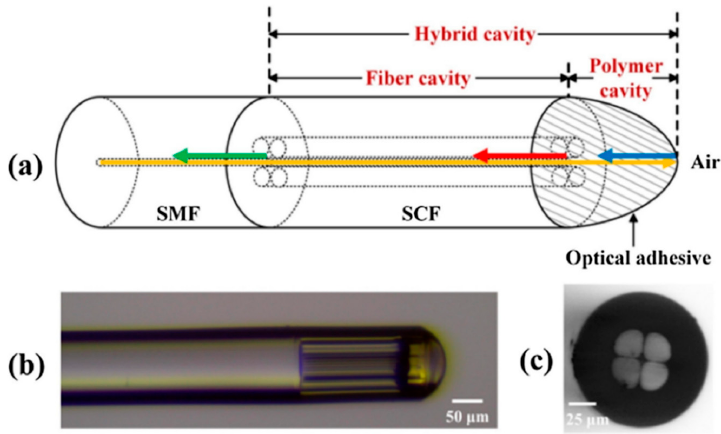
Figure 20. (a) Scheme of the different parts of the MOF sensor. The hybrid cavity is formed by the SSC Figure 20. ( a ) Scheme of the di ff erent parts of the MOF sensor. The hybrid cavity is formed by the cavity (SCF in the figure) and by the polymer cavity, formed by the OA; (b) Microscope image SSC cavity (SCF in the figure) and by the polymer cavity, formed by the OA; ( b ) Microscope image obtained of the developed MOF sensor; (c) Cross section of the 4-hole SSC. Reprinted with permission obtained of the developed MOF sensor; ( c ) Cross section of the 4-hole SSC. Reprinted with permission from [125]. from